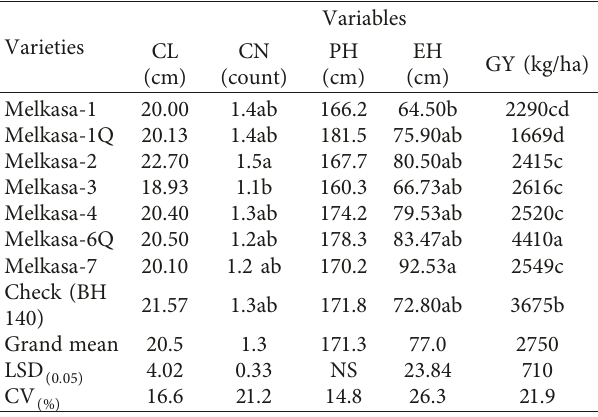
Table 4: Mean values of agronomic traits for maize varieties at Salayish and Angila-4 locations during 2018 in Basketo special and Melokoza districts, Southern